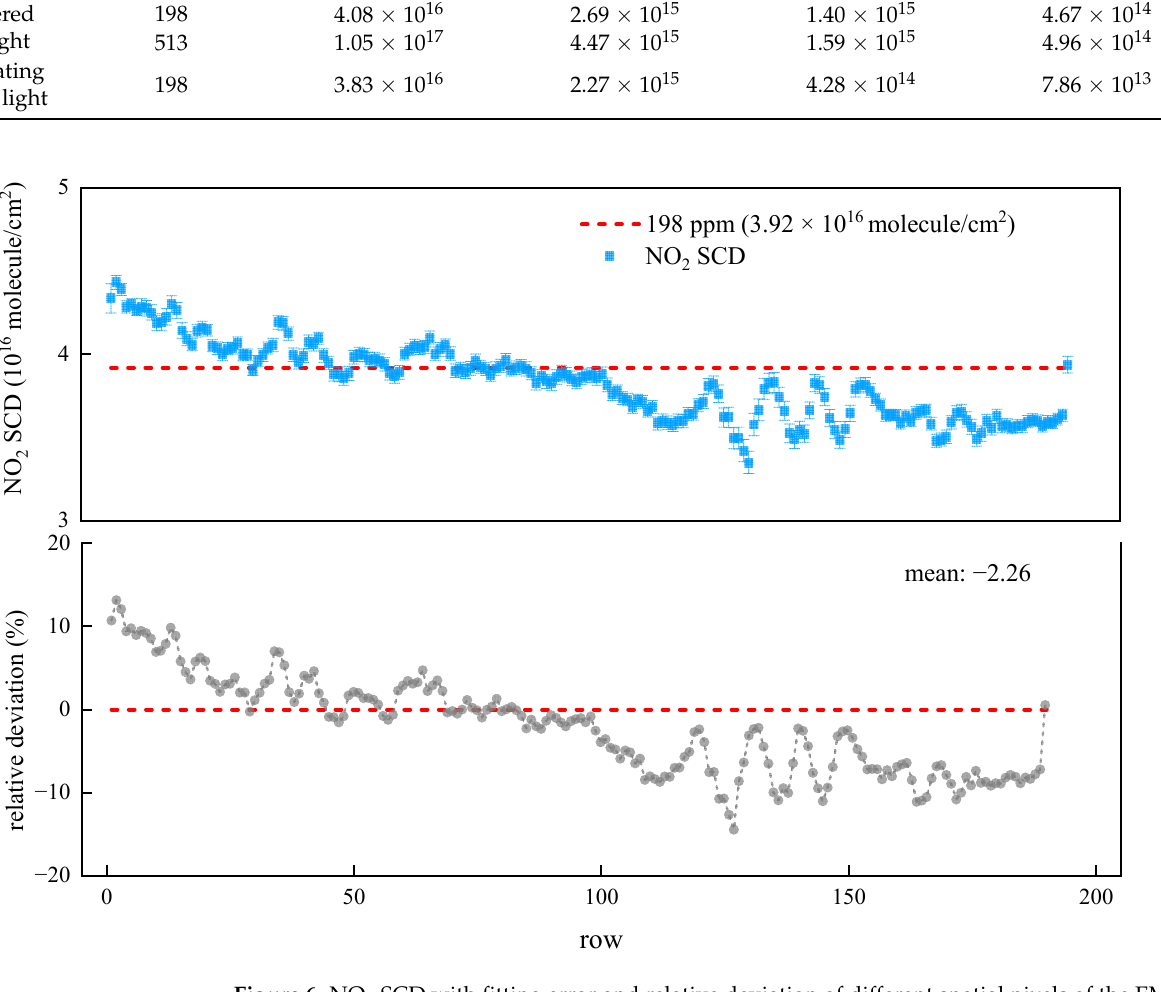
Figure 6. NO 2 SCD with fitting error and relative deviation of different spatial pixels of the EMI-NL nadir module with integrating sphere and an NO 2 sample gas concentration of 198 ppm. Table 3. NO 2 gas cell measurement results of the nadir module.